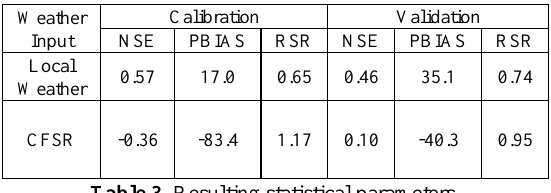
Table 3. Resulting statistical parameters.